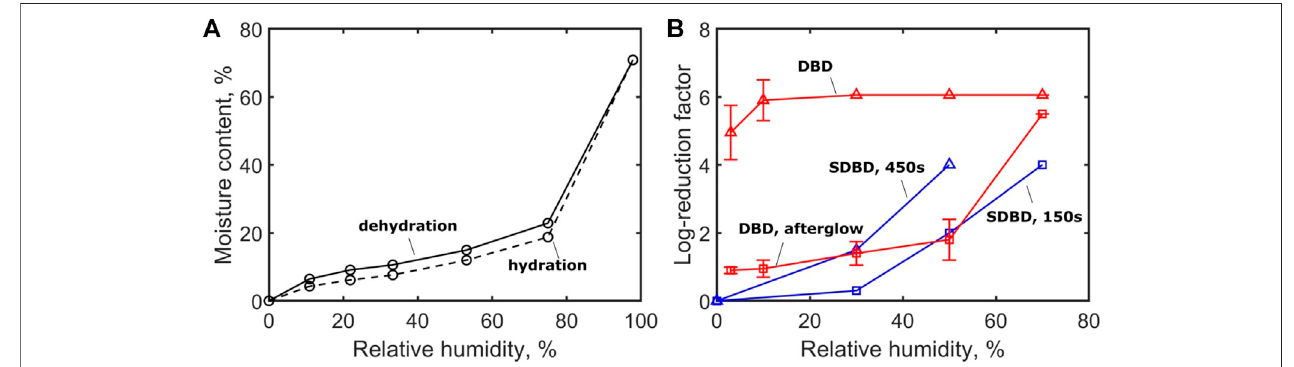
FIGURE2| Effectofairrelativehumidityon (A) themoisturecontentof B.Subtilis incontactwithairat25 ° Cestimatedfromwaterdesorptionofwetcellsandwater adsorption of dessicated cells [37], and (B) the inactivation of B. Atrophaeus endospore by direct ( Δ ) and post-discharge ( □ ) DBD treatment [38], and surface DBD (SDBD) after exposures of 150 s ( □ ) and 450 s ( Δ ), [39].